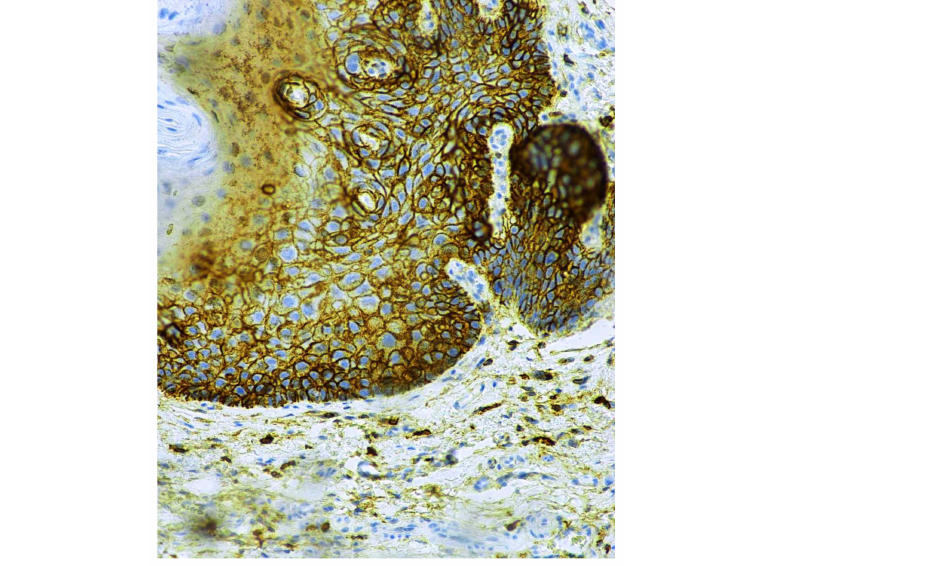
In oral leukoplakias, CD9 expression was detected in the cell membrane at the same areas as CD44 and in an identical number of epithelial cell layers. CD9 was not observed in the upper part of OL and in the places with keratohyalin granules. The pattern of CD44 expression in the cell membrane was like a smooth line, while CD9 antigen presence presented some thickening, causing the membrane to become corrugated (Figure 9).